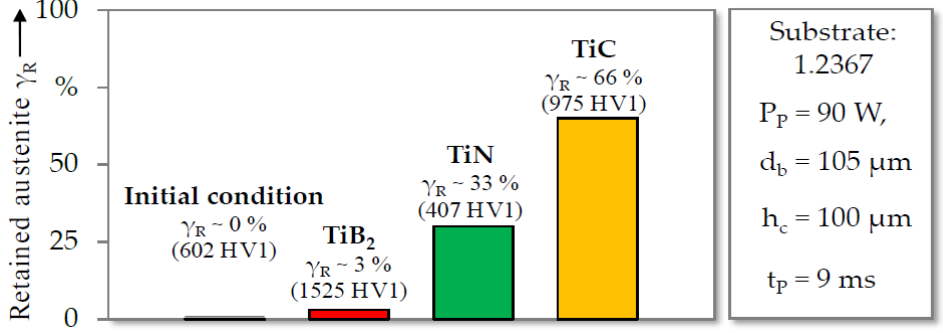
ff erent material